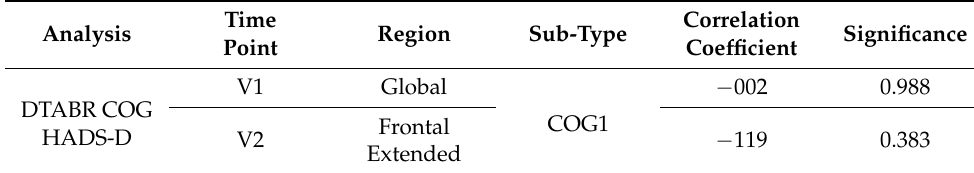
Table 5. Non-significant